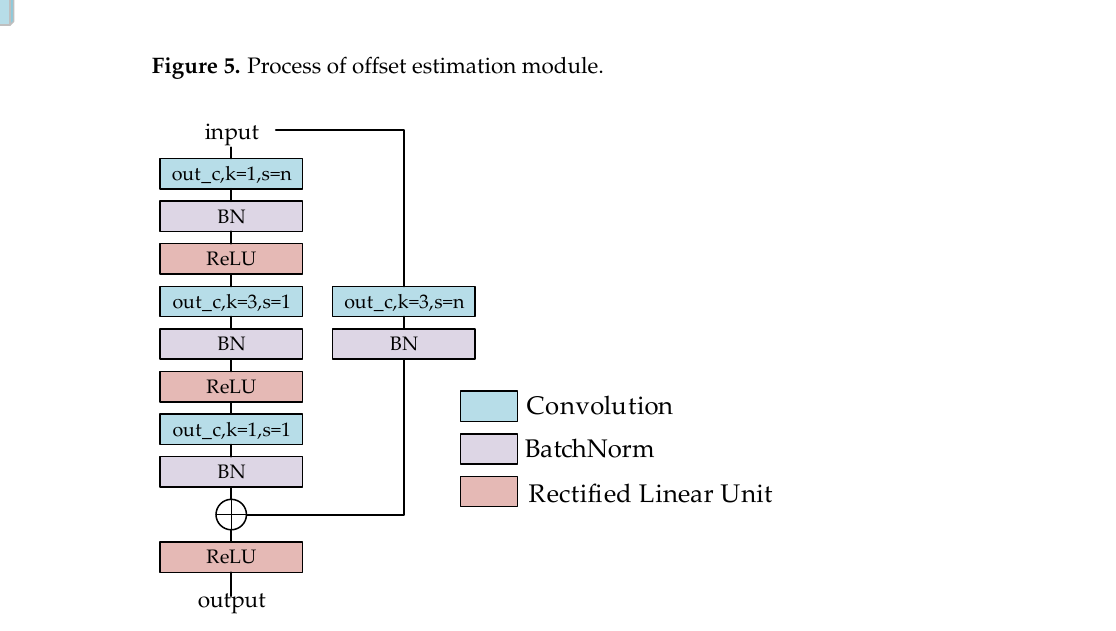
Figure 6. Bottleneck structure. In a convolutional block, the first parameter is the output channel, the second parameter is the convolutional kernel size, and the third parameter represents the step size.